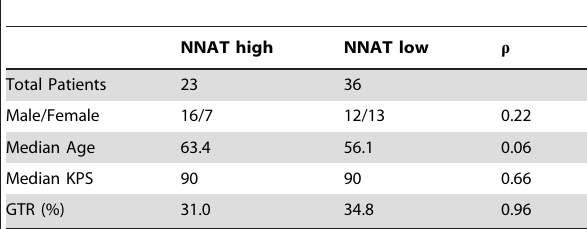
Table 1. Patient demographics.